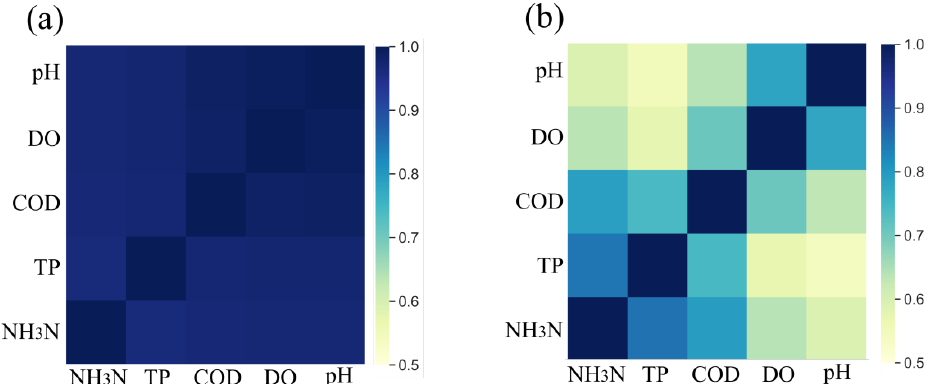
Figure 5. Grey correlation coefficients using two scaling methods. ( a ) Original data are scaled by the first data array; ( b ) original data are scaled by the max-min